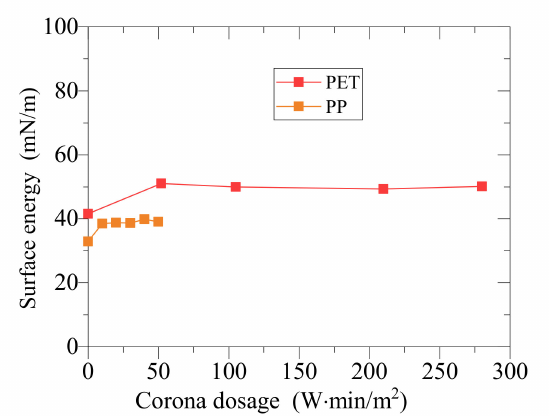
Figure 3. Surface energy of polyethylene terephthalate (PET) and polypropylene (PP) before and after corona treatment at various dosages. Each value is a mean of n = 5 measurements.